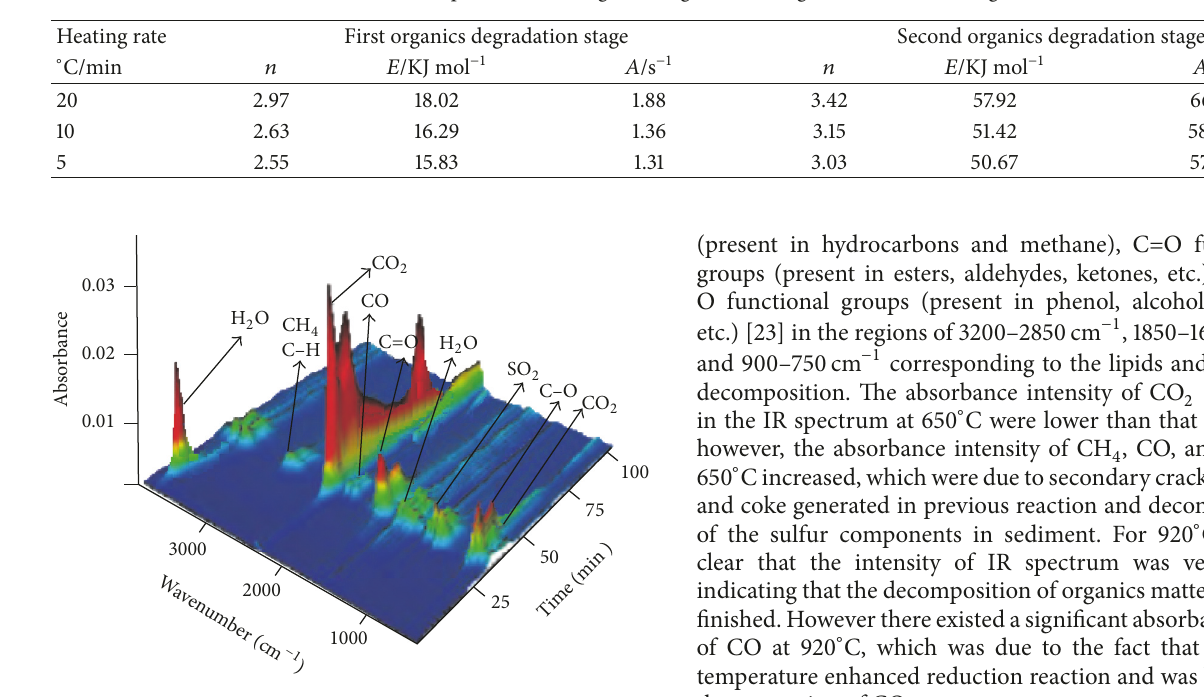
Table 4: Kinetic parameters of organics degradation stages at different heating rates.